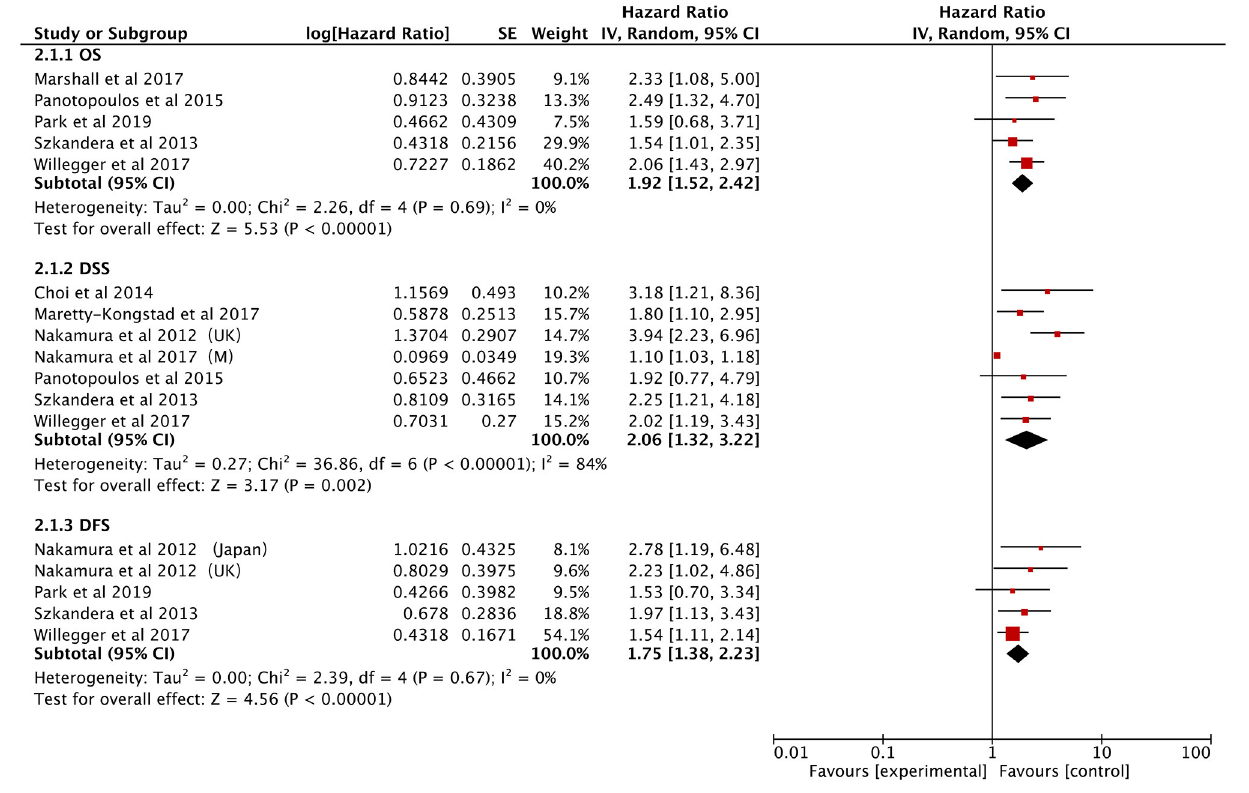
FIGURE 4 | Forest plots of the Prognostic effect of CRP for